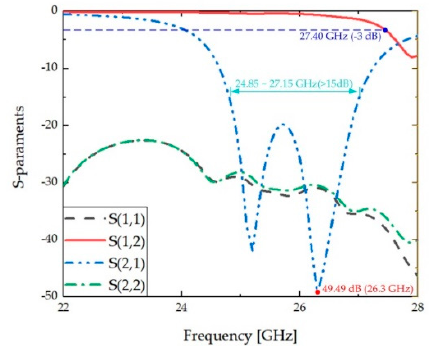
Figure 6. The variation of transmission characteristics of MO isolator with frequency.